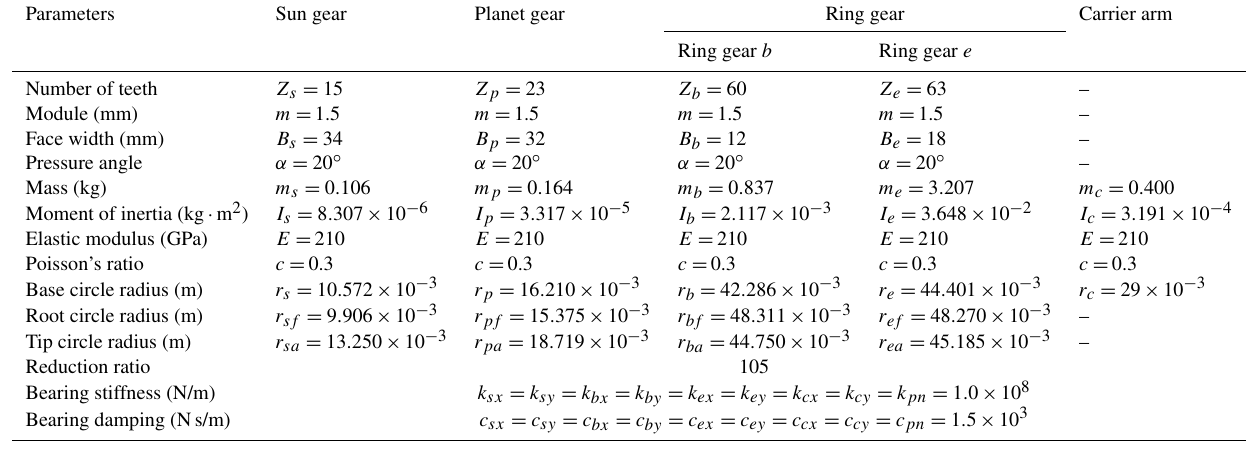
Table 1. The 3K-II planetary gear set parameters. Parameters